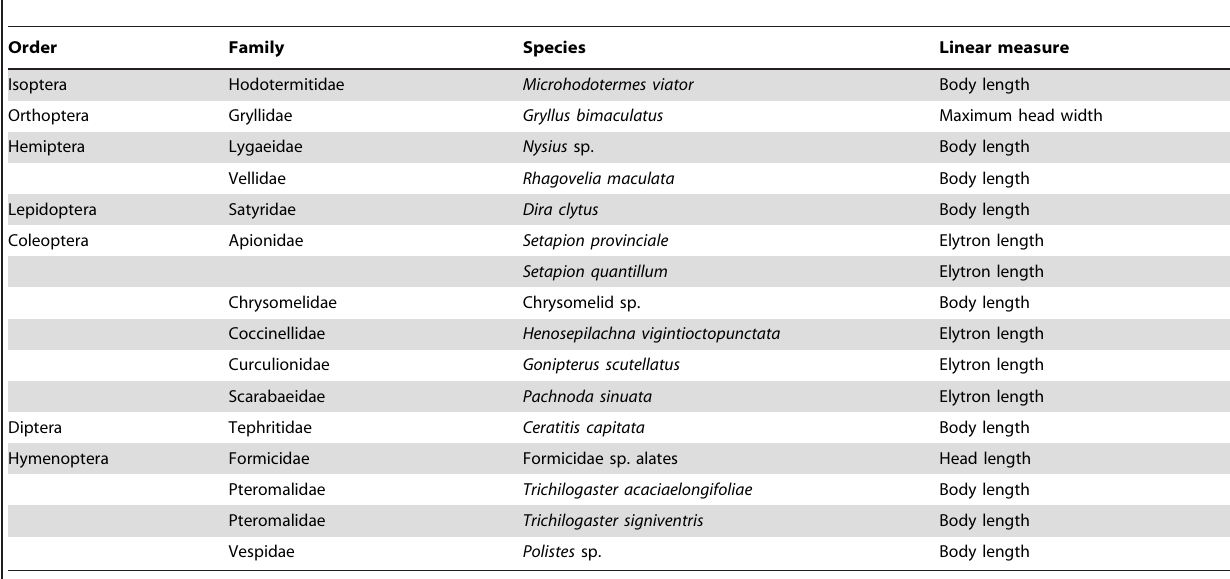
Table 1. The 16 insect species collected for this study indicating the linear measurement used to estimate